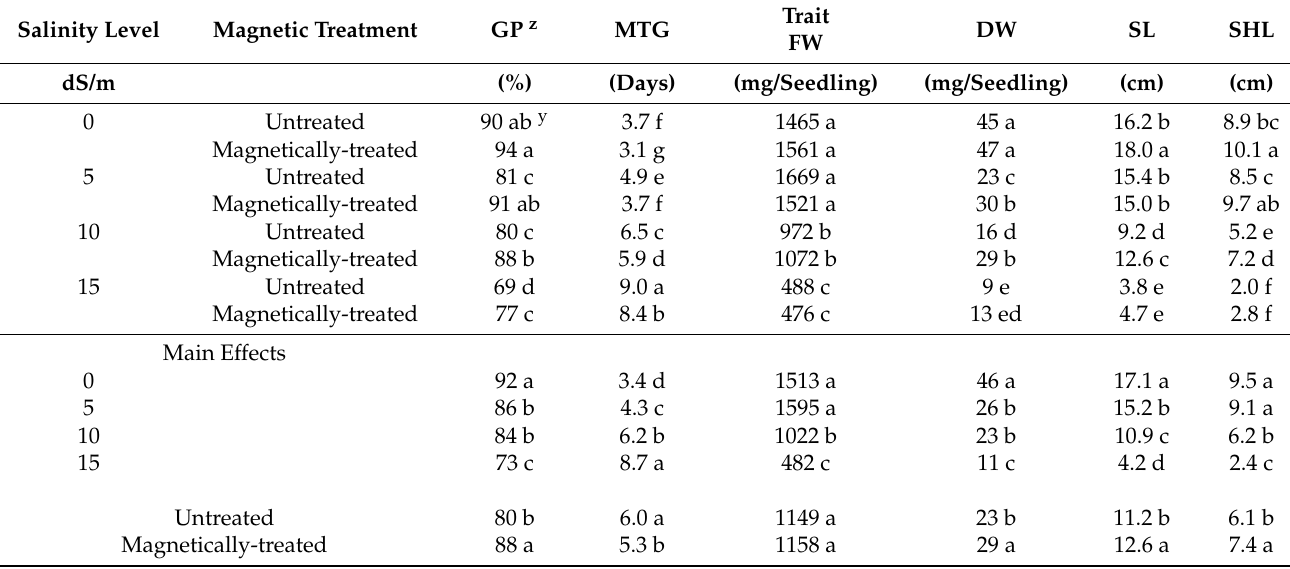
Table 1. Effect of magnetically-treated water at different levels of water salinity on tomato seed germination percentage, mean time to germination, seedling fresh weight, seedling dry weight, seedling length, and shoot length in a standard germination test at 25 ◦